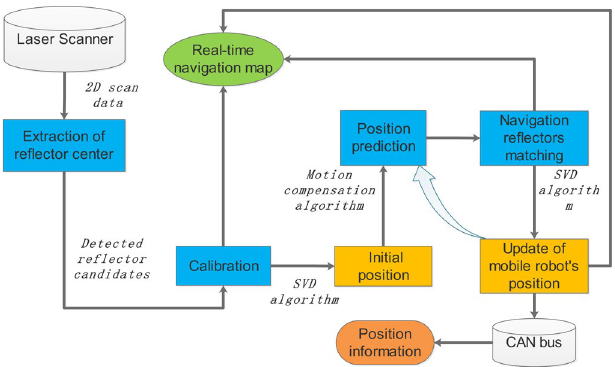
Figure 2. “SORLA” program architecture diagram.